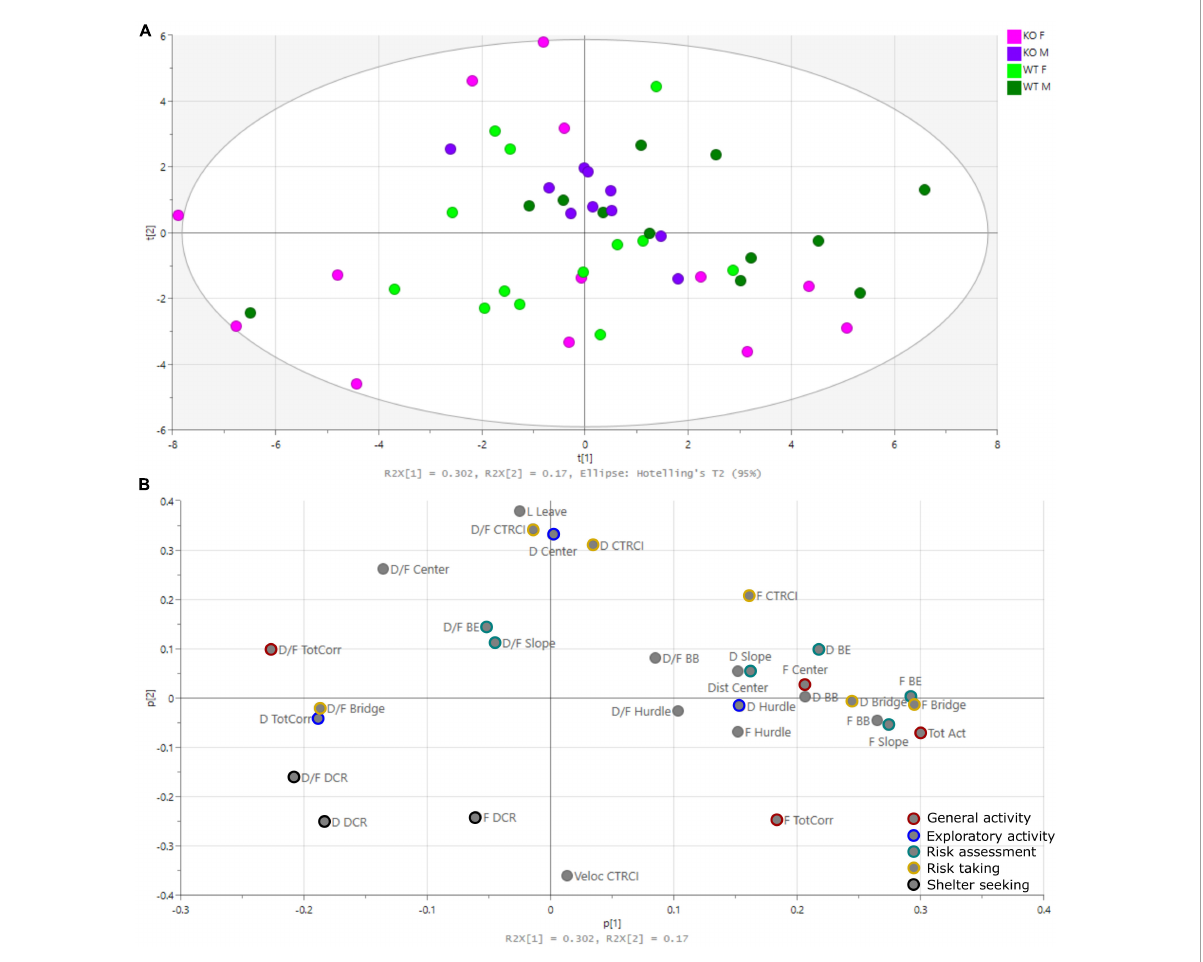
FIGURE3 Principal component analysis (PCA). (A) Score plot showing the individual animals and (B) loading plot showing the parameters of importance for the individual loadings [one significant component with one non-significant component added: R2X(cum) = 0.472, Q2X(cum) = 0.278]. Parameters used in trend analysis are color-coded. BB, beyond bridge; BE, bridge entrance; CTRCI, central circle; DCR, dark corner room; Dist, distance; D, duration; D/F, duration/visit; F, frequency; L, latency; Tot Act, total activity; TotCorr, total